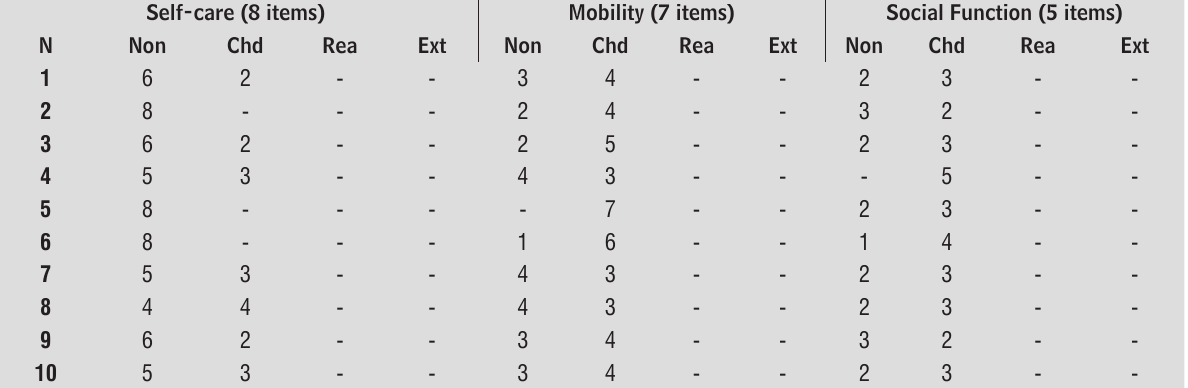
Table 2 - Frequency of responses concerning Part III - Change in Environment for control group (n = 10)